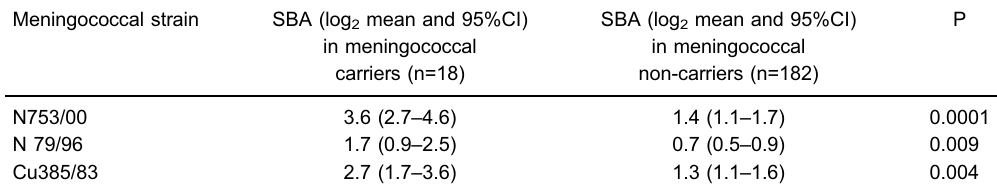
Table 2. Serum bactericidal antibody (SBA) against meningococcus serogroup C and meningococcus serogroup B strains in carriers and non-carriers of Neisseria meningitidis. Meningococcal strain